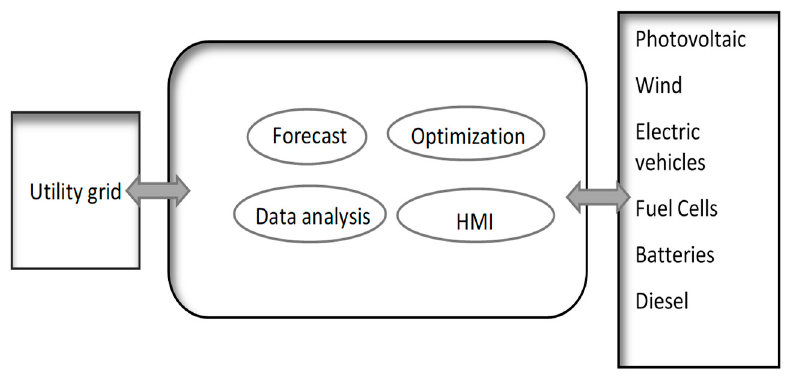
Figure 2. Microgrid energy management [29].